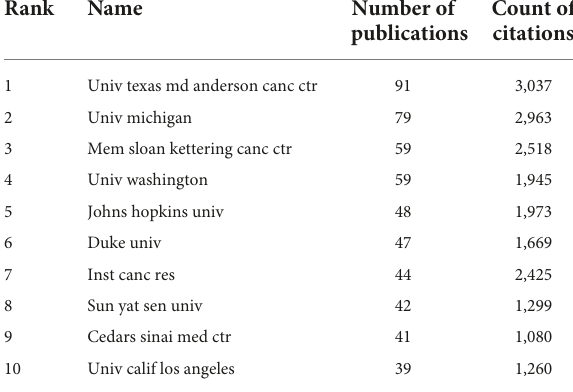
TABLE 1 The top 10 most active authors related to PCa bone metastasis.